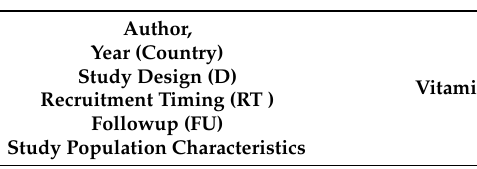
Table 1. Included